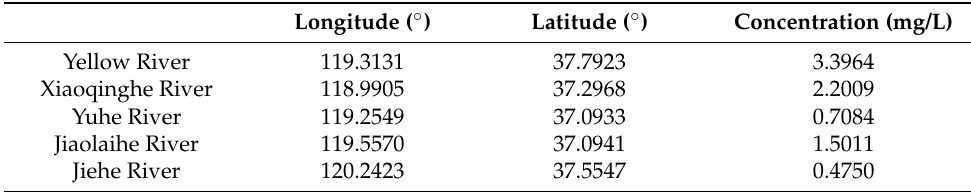
Table 1. Concentration value setting at the estuaries.